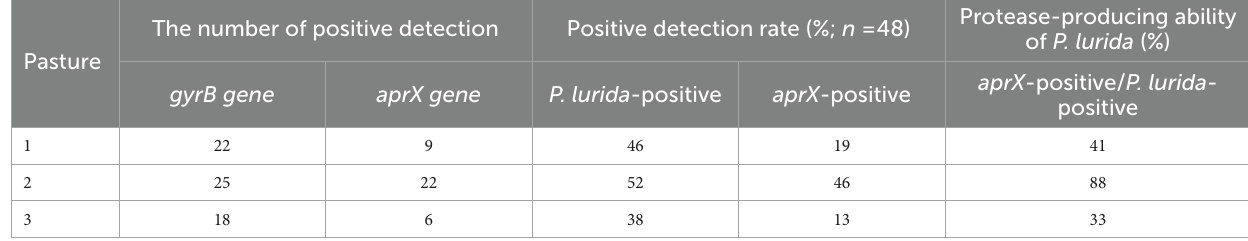
n = 48: 48 samples were collected from each